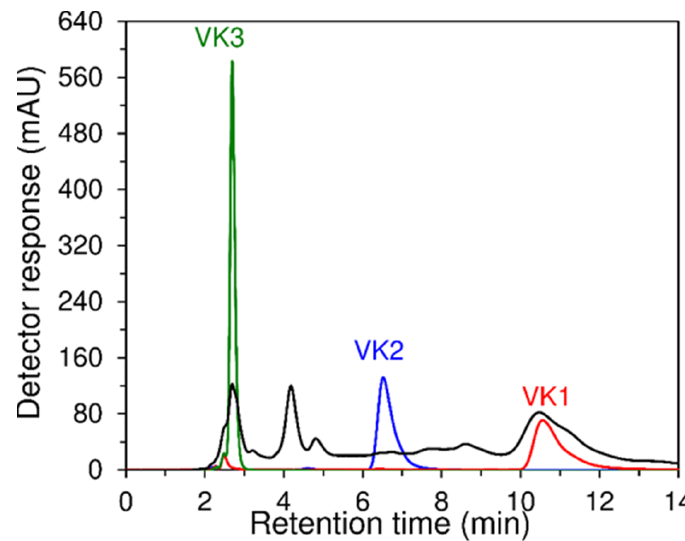
Figure 6. HPLC analyses of food supplement VITAMÍN K2 MK 7 + D3 FORTE (black line) and standard solutions of 10 mg L −1 VK1, VK2 and VK3. KinetexTM PFP 100 Å column (150 × 3 mm, particle size of 2.6 µm), mobile phase of water/methanol (10/90 v/v ), flow rate of 0.3 mL min −1 , sample volume of 10 µL, temperature 40 °C, detection at 246 nm.